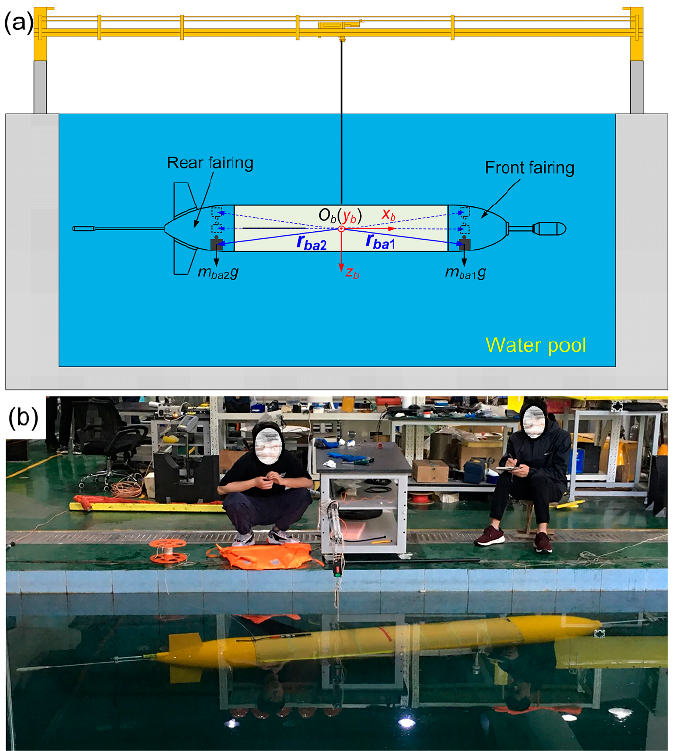
Figure 13. Ballast method to regulate the initial equilibrium state of Petrel-X PLUS : ( a ) Schematic diagram of ballast method; ( b ) Petrel-X PLUS in a water pool.